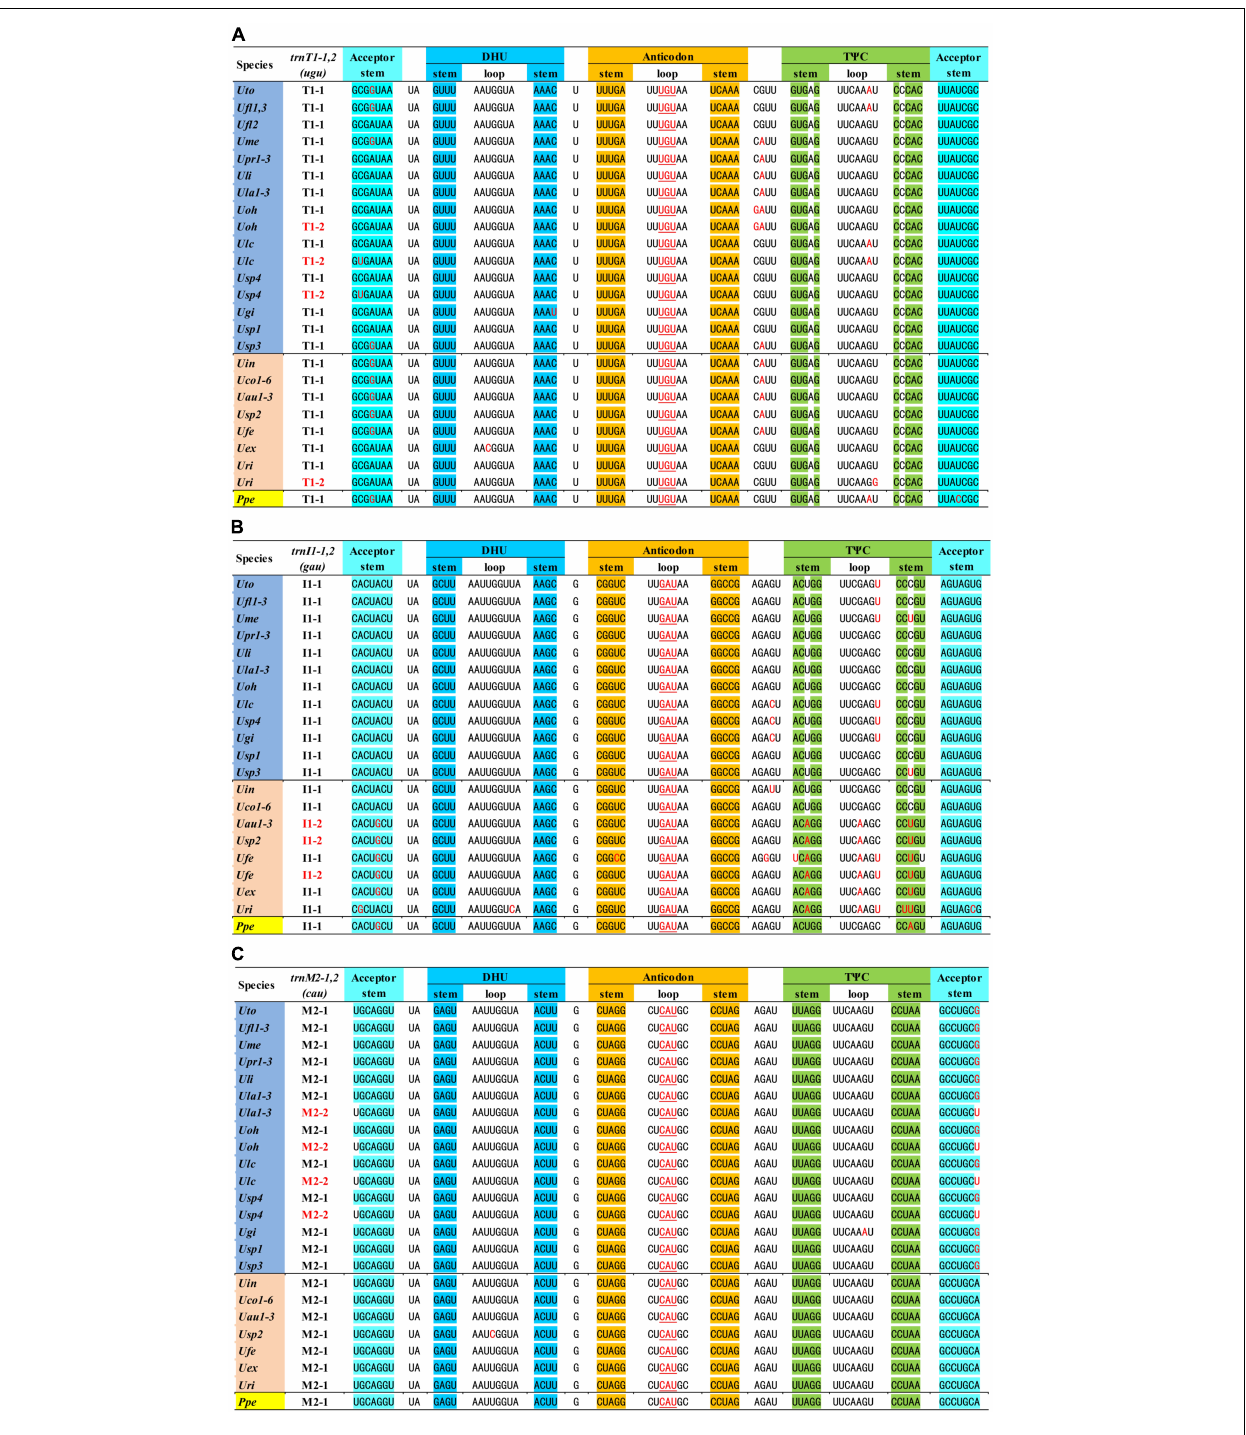
FIGURE 3 | The aligned sequences of three tRNA genes with duplication mutation in Ulva mitogenomes. (A) trnT1(ugu) . (B) trnI1(gau) . (C) trnM2(cau) . Shaded nucleotides indicated that bases could be